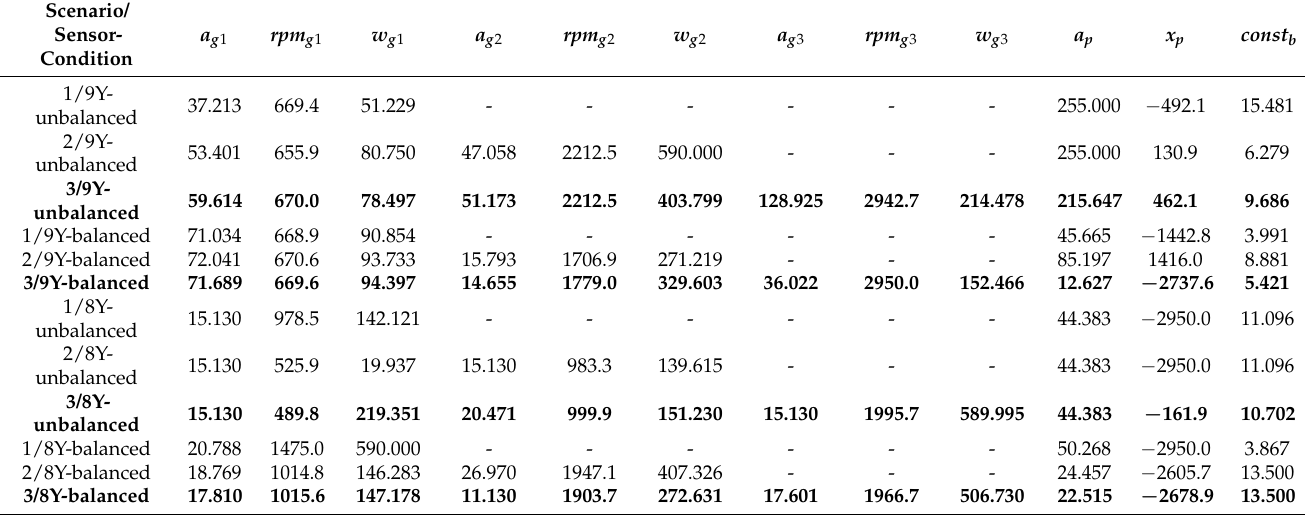
Table 8. Decomposed function parameters identified by DE algorithm. Function parameters in imbalance and healthy condition. The MD3 scenario selection number is highlighted in bold font.